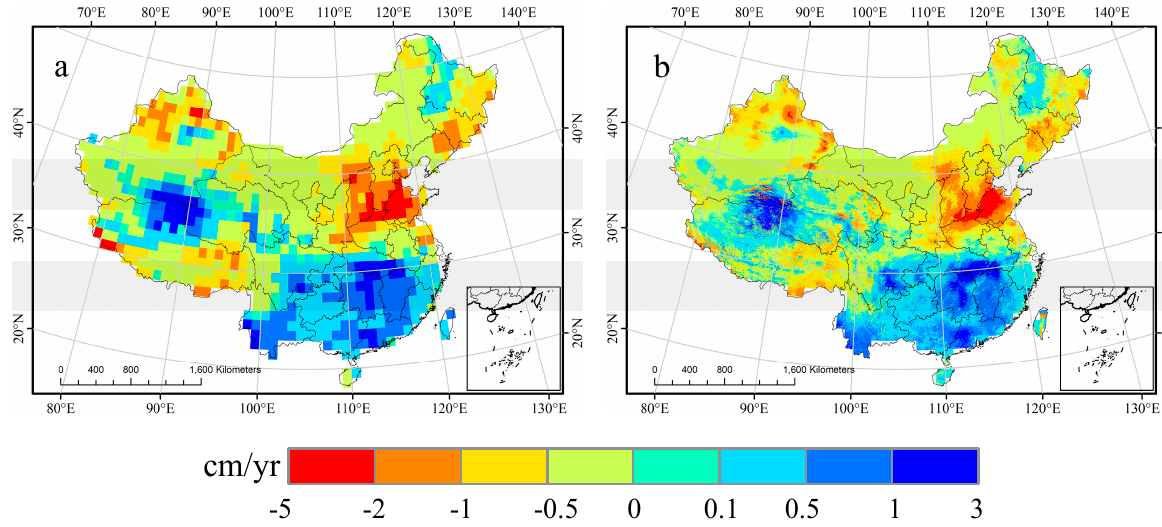
Figure 9. Thiel-Sen’s slope before and after downscaling the GRACE GWS for 2004–2016. ( a ) Slope of the original GWS; ( b ) Slope of the XGBoost-downscaled GWS.